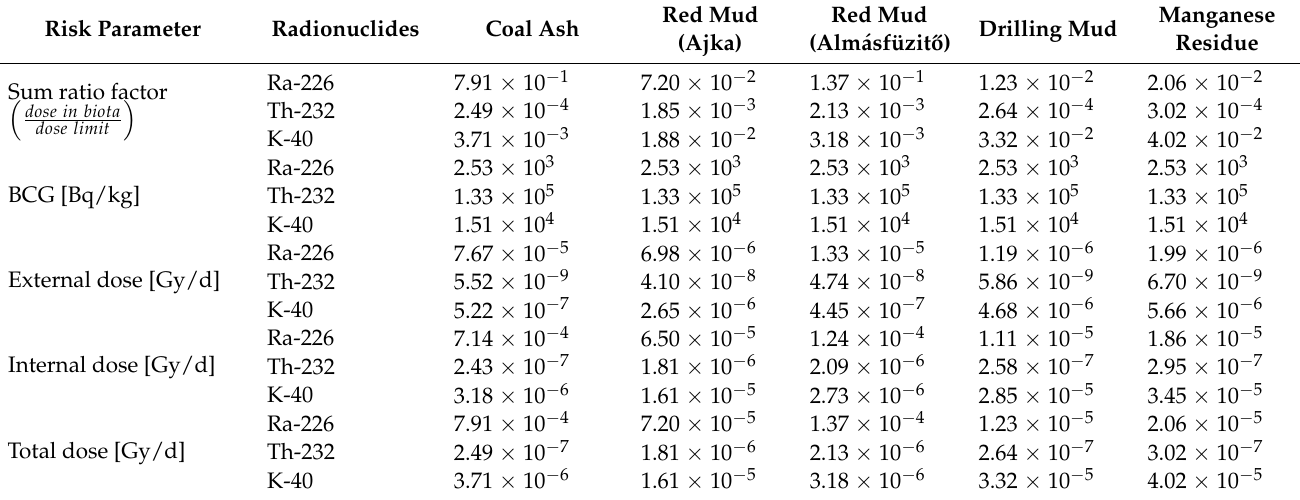
Table 6. Risk parameter in terms of radionuclides and materials (800